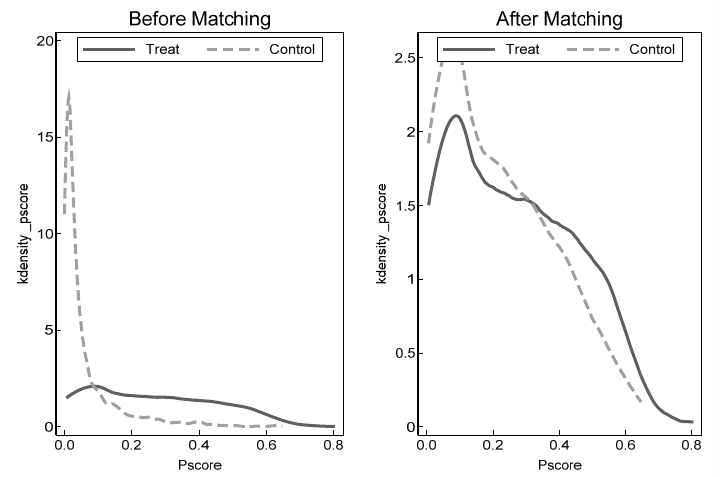
Figure 2. Comparison of propensity score distribution between treatment group and control group before and after PSM. Table 5. PSM and balance test results.